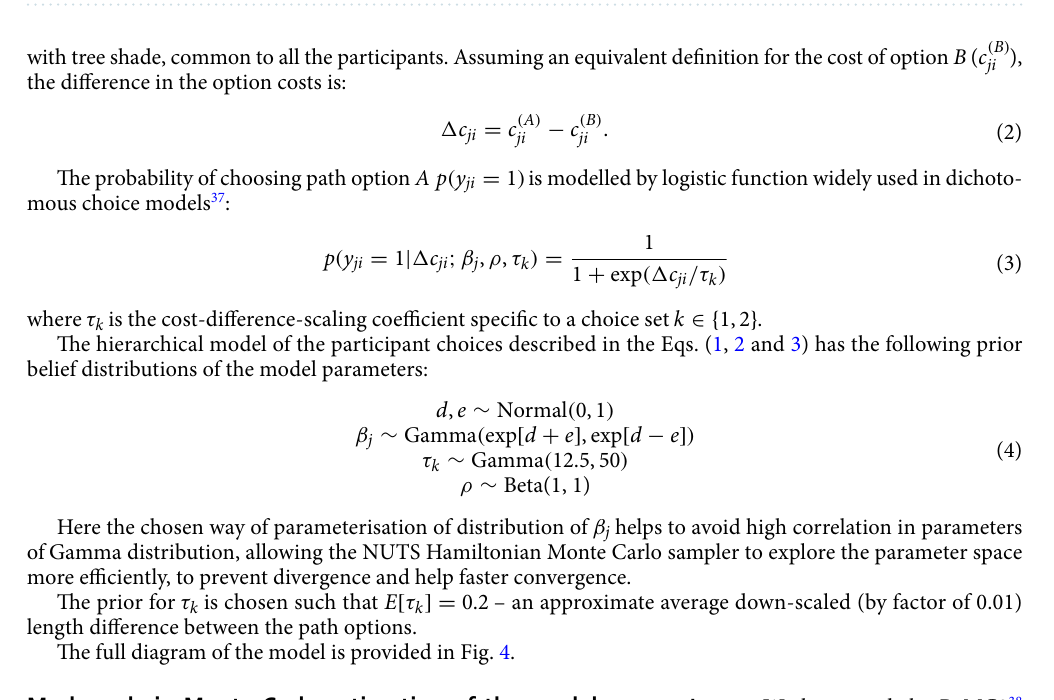
Figure 4. Graphical representation of the hierarchical model of path choices. All variables are continuous except binary y ji . Observed variables are shaded, unobserved are not shaded. Of unobserved variables, stochastic ones are single-bordered, deterministic are double-bordered. The figure is generated with use of package daft v0.1.0 (https:// docs. daft- pgm. org/ en/ latest/) for Python